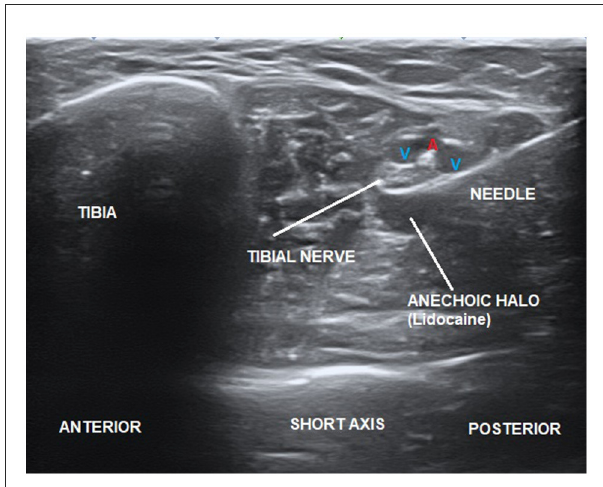
FIGURE1 Ultrasound-guided injection of lidocaine close to the tibial nerve producing an anechoic halo.